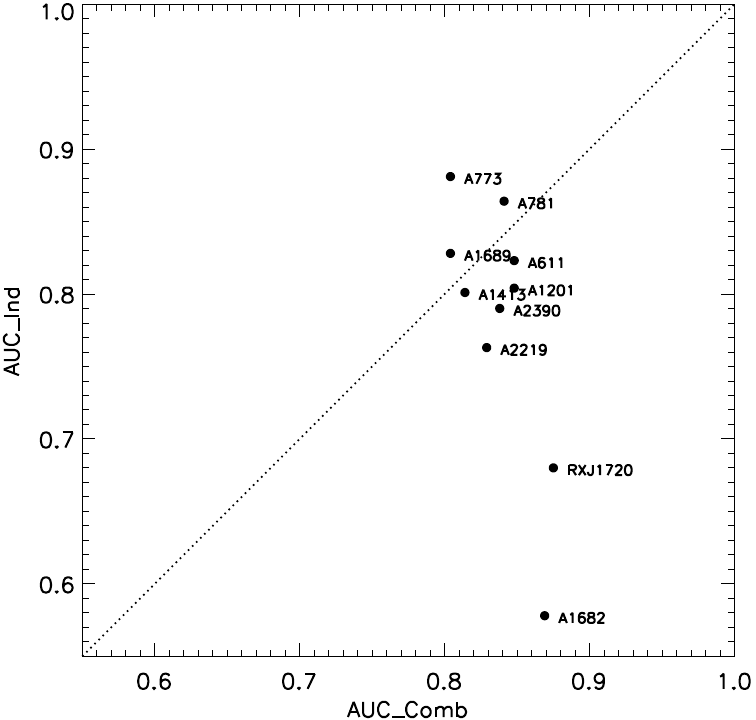
Figure 5. Comparison of combined cluster training and individual cluster training. A diagonal line is where the combined and individual trainings produce the same AUC